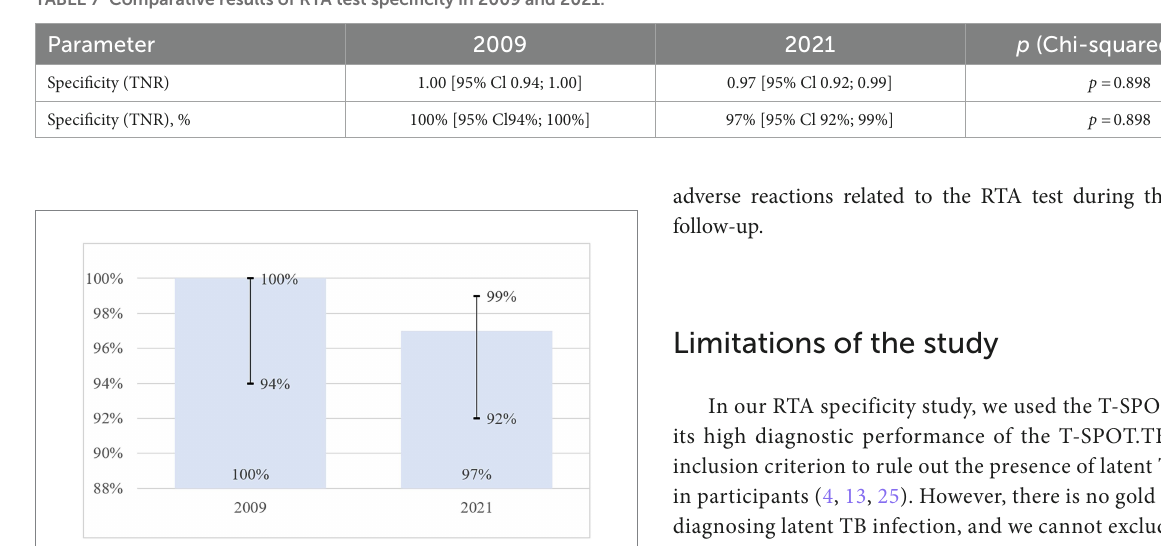
FIGURE 2 Comparative results of RTA test specificity in 2009 and